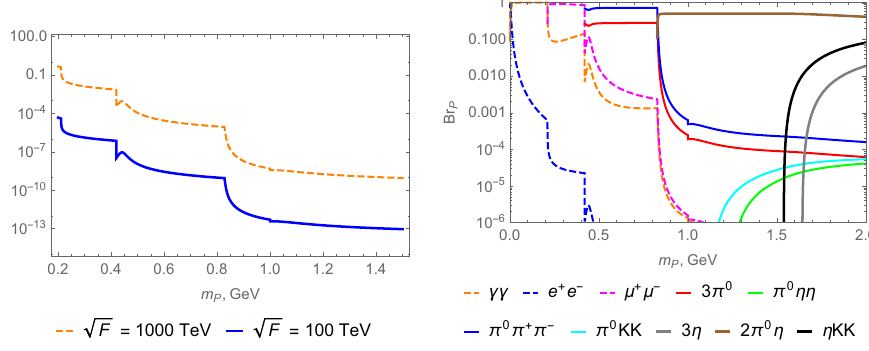
√ F = 100 , 1000TeV (lines from bottom to top) (on the left